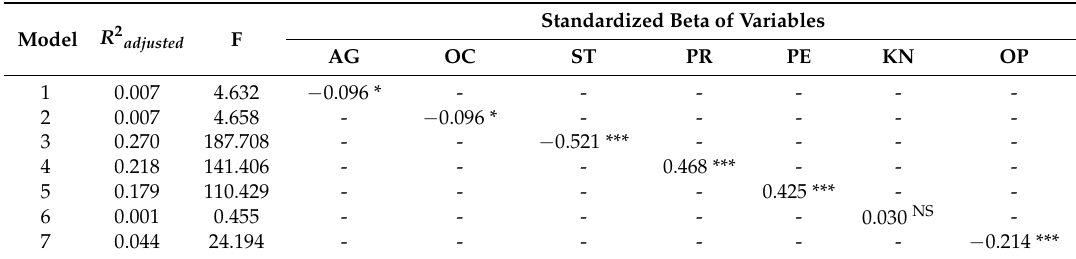
Table 4. Summary of individual effect levels on anxiety by linear regression analyses of age, occupation, social trust, perceived risk, pessimism, knowledge, and optimism,